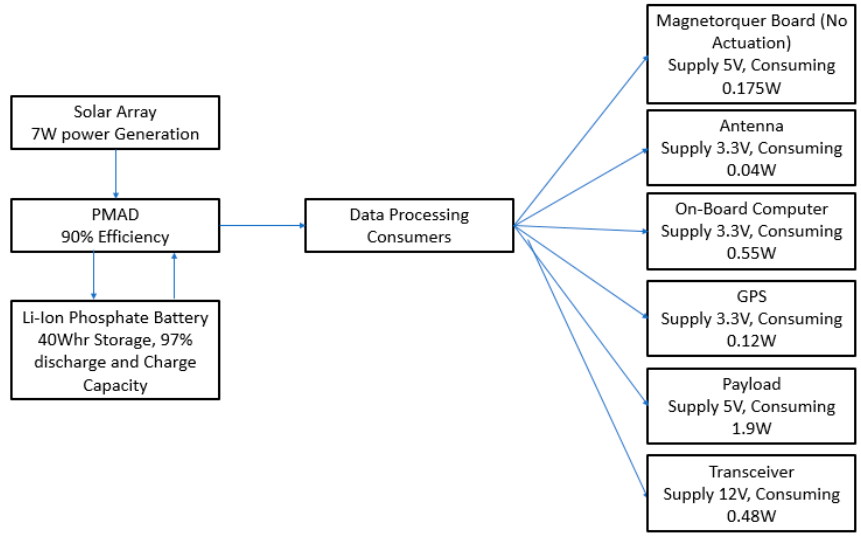
Figure 40. Data Processing Block Diagram.